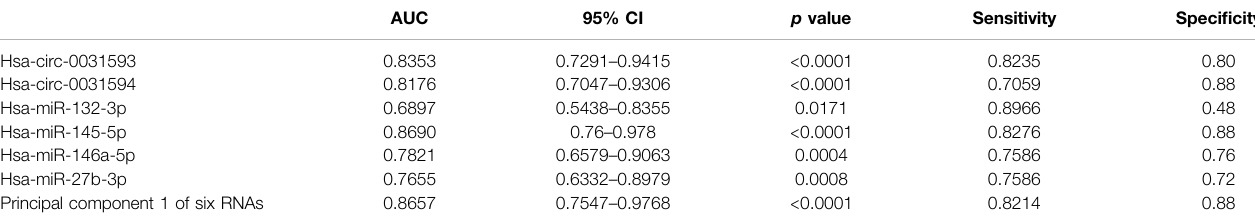
TABLE 1 | Validation of the selected circRNAs and miRNAS by quantitative real-time polymerase chain reaction and the data of ROC curve